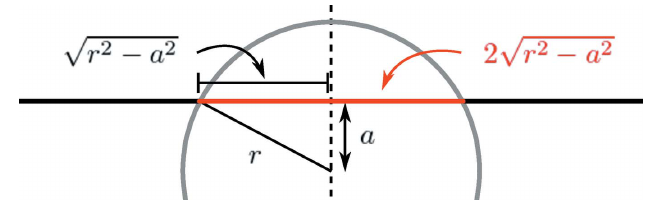
Figure 3 Schematic representation of the computation of the intersection (red) of a ray (black) and the main cylinder or a void (gray). The radius of the cylinder or void is given by r , and the closest distance between the ray and the center of the cylinder or void is given by a . The length of the intersection is then equal to 2( r 2 (cid:5) a 2 ) 1/2